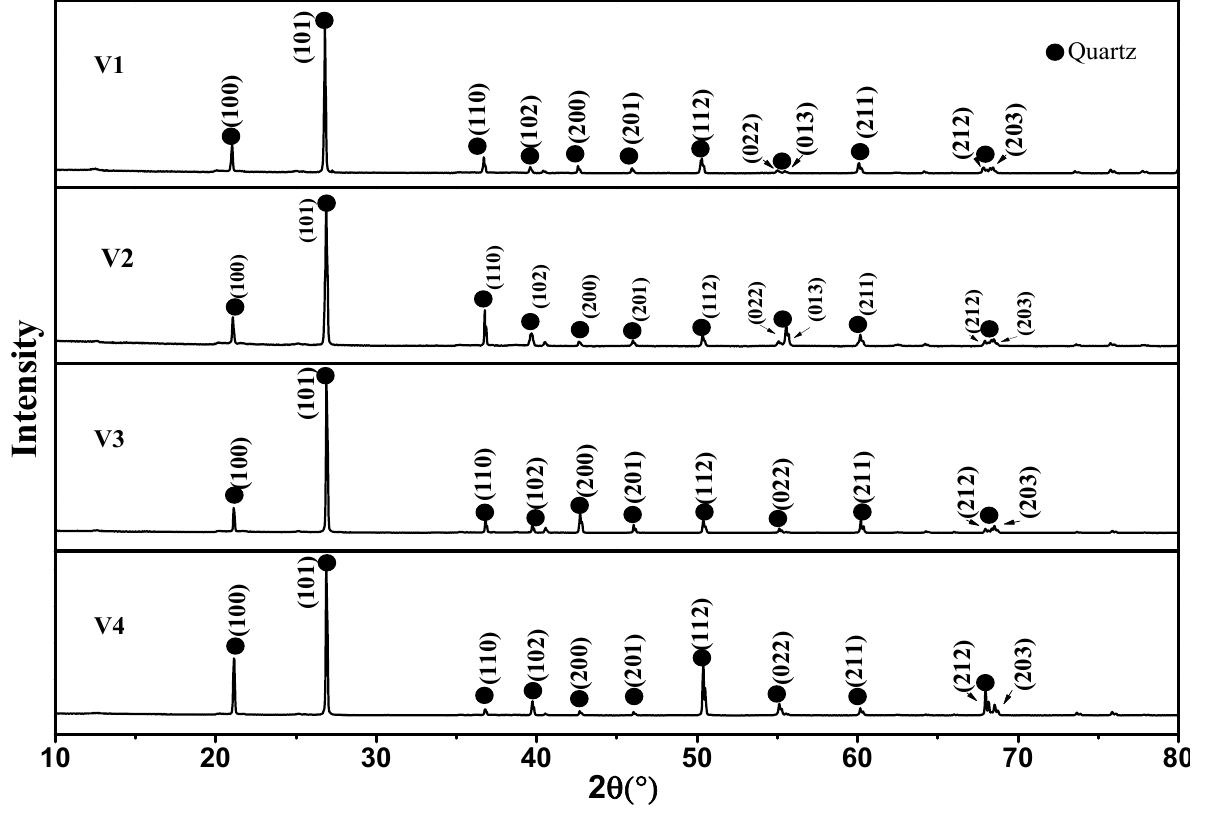
Figure 3. X-ray diffraction of soil samples. The silica phase (quartz) was identified using Match v3 software.